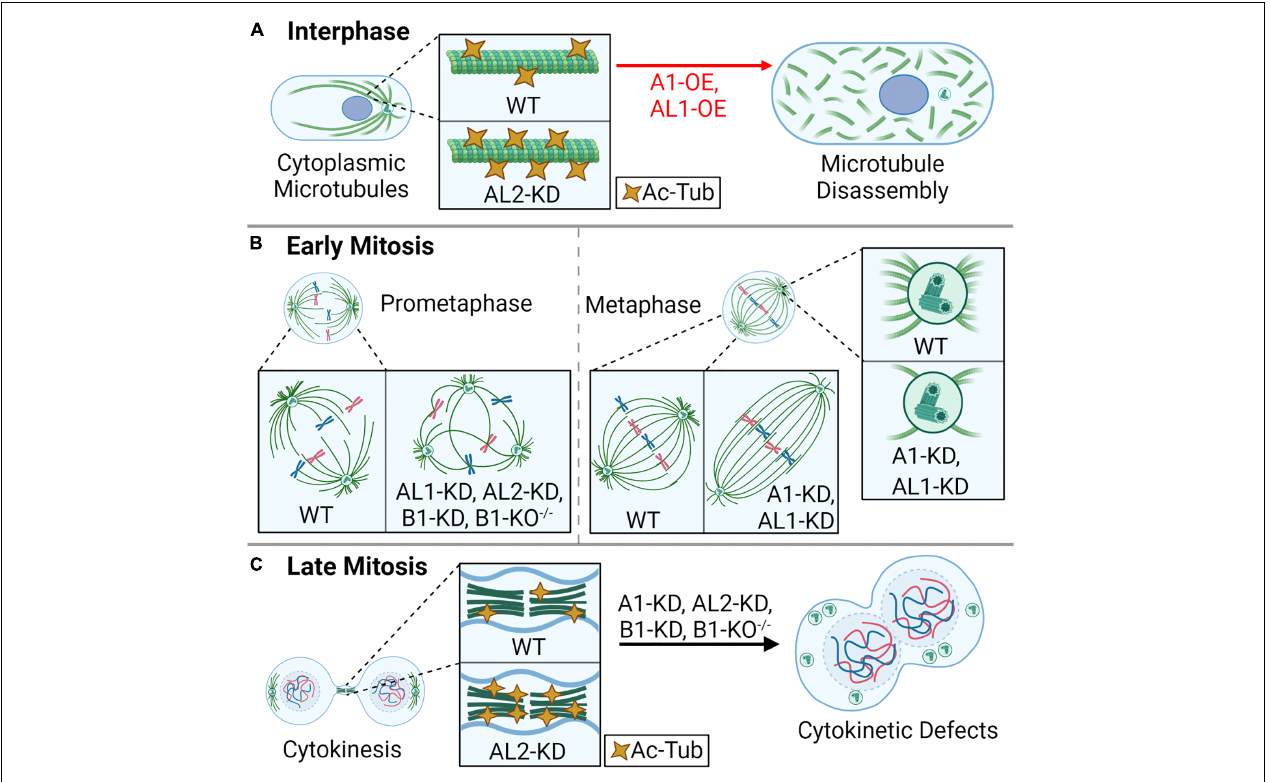
FIGURE 2 | Katanin function in the cell cycle. During the cell division cycle, the katanins are important for cytoplasmic microtubule rearrangements, mitotic spindle assembly, and proper cytokinesis. (A) In interphase, overexpression (OE) of A1 or AL1 leads to rapid disassembly of the microtubule lattice, and AL2 knockdown (KD) leads to hyper-acetylated tubulin (Ac-Tub). (B) In early mitosis (prometaphase), KD of AL1, AL2, or B1, or homozygous knockout of B1 (B1-KO – / – ) leads to multipolar spindles; KD of A1 or AL1 leads to an elongated spindle; KD of A1 or AL1 also leads to a reduction of aster microtubule density at the spindle poles. (C) In late mitosis, KD of A1, AL2, or B1, or homozygous knockout of B1 (B1-KO – / – ) leads to cytokinesis failure, enlarged cells with large nuclei, and supernumerary centrioles. KD of AL2 also leads to hyper-Ac-Tub at intercellular bridge